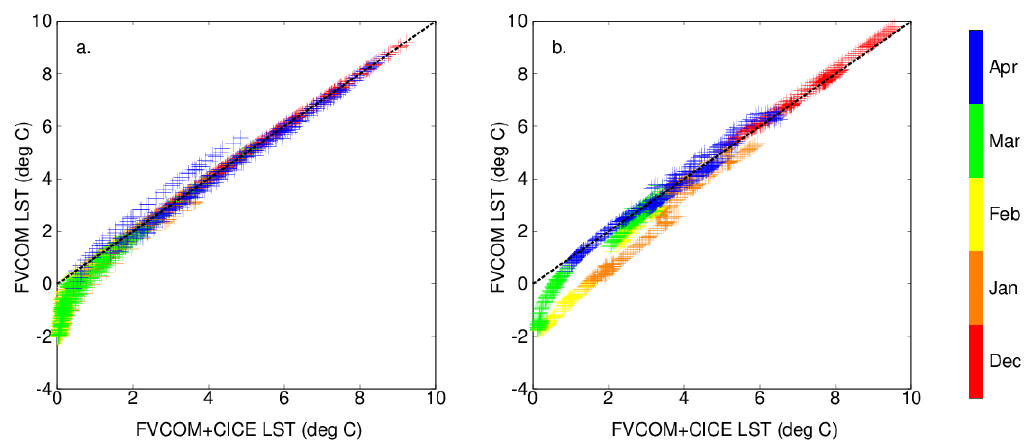
Figure 12. Lake surface temperature (LST) for Lake Erie ( left ) and Lake Michigan-Huron ( right ) for simulations of FVCOM with and without CICE during the winter months.